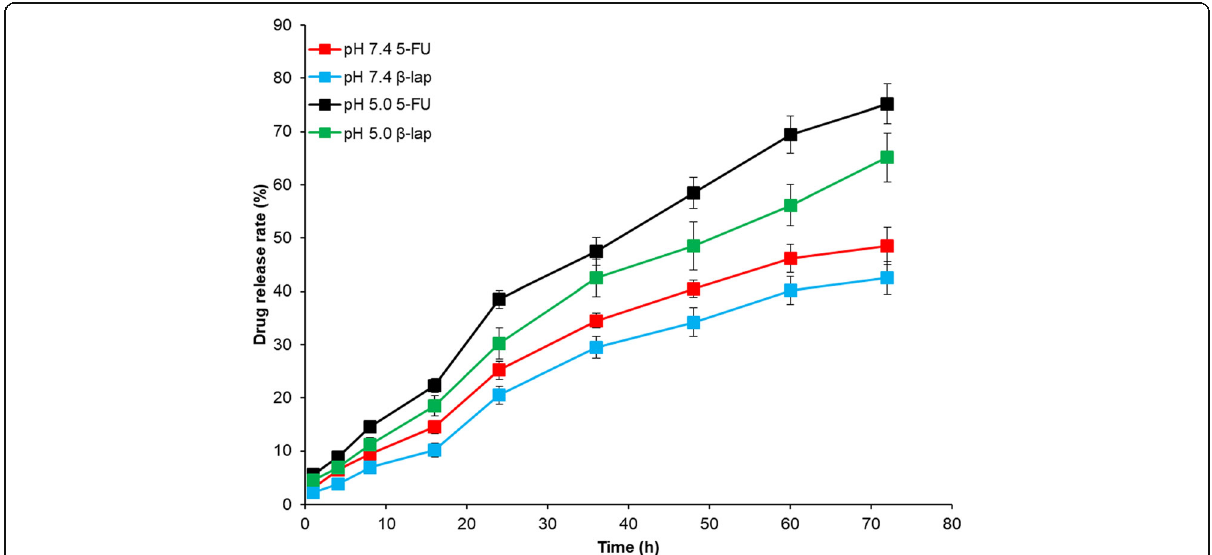
Fig. 2 In vitro release of 5-FU and ß-lap from FNQ-MSN in pH 7.4 and pH 5.0 buffer conditions. The release study was continued until 72 h, and drug release was quantified using HPLC method. ** p <